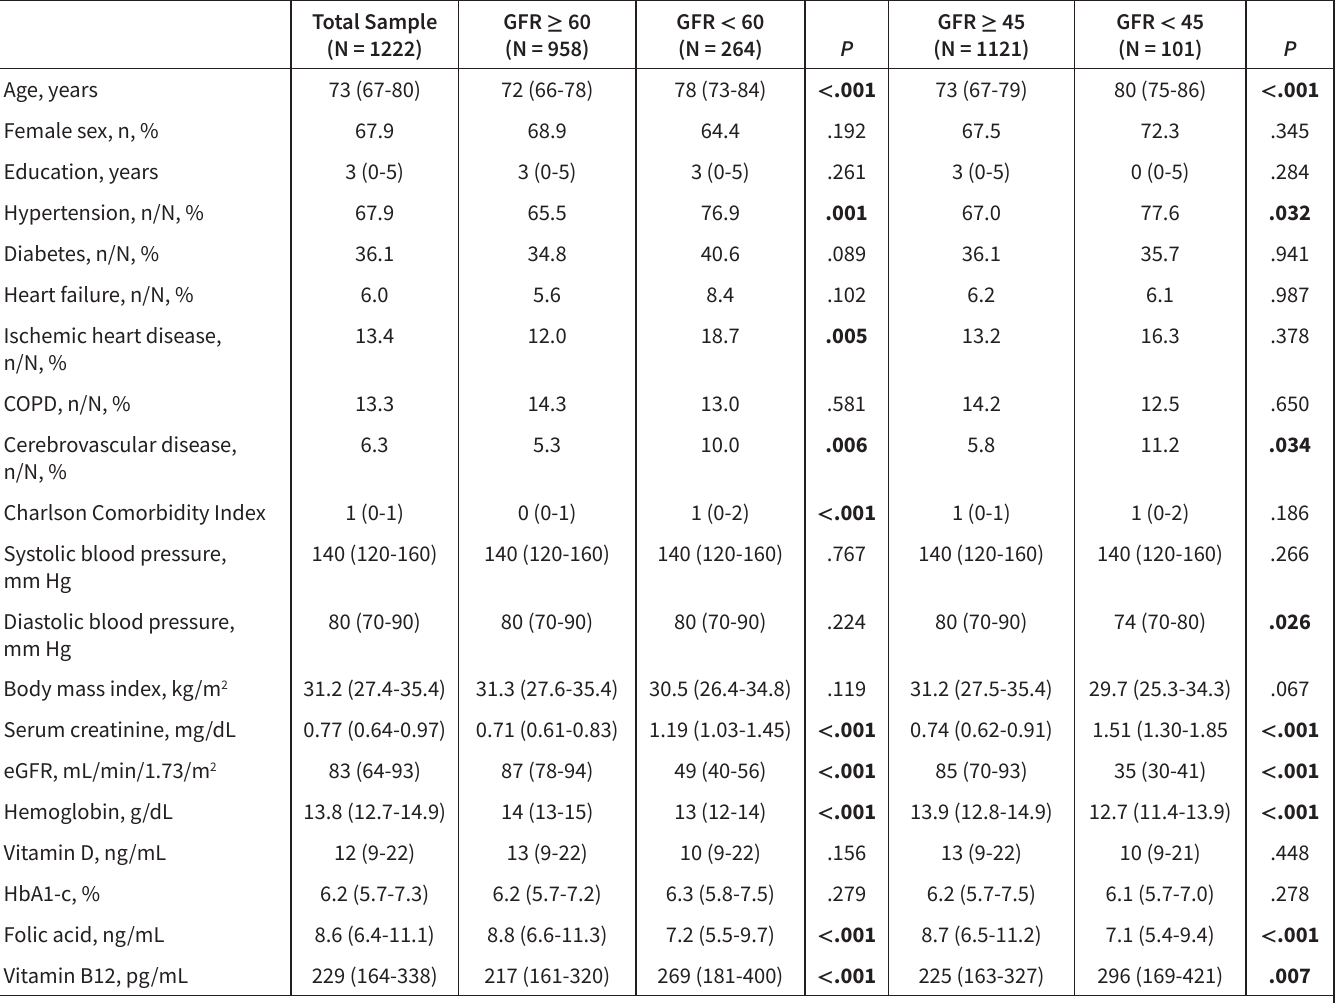
Table 1. Demographic and Clinical Characteristics of Subjects According to 2 Different Cut-Off Values of Glomerular Filtration